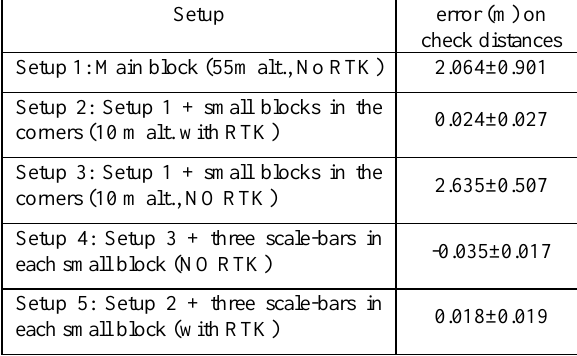
Table 3. Results of different setups in the first